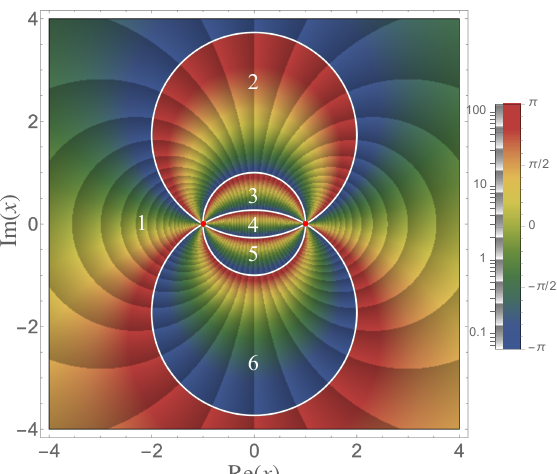
Figure 2 . Plot of v ( x ) for n 1 = n 2 = 3 . Colors depicts the phase of v ( x ) , and the shading follows the curves of con- stant | v ( x ) | , as indicated by the scales. The x -plane is divided into H = 6 re- gions, v ( x ) taking all values in C inside of